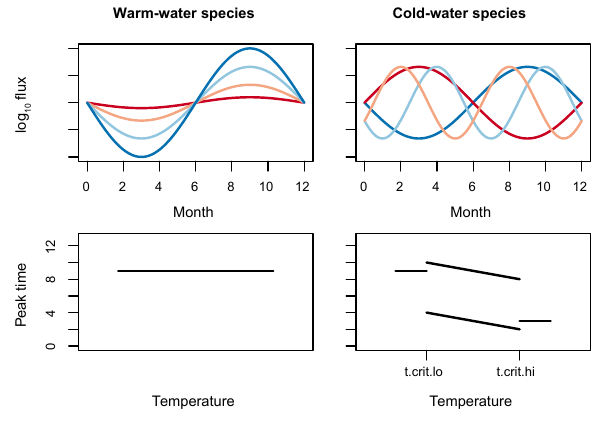
Figure 3. Schematic representation of the seasonality model. Upper panels show the annual flux patterns; colours indicate temperature, where blue is cold and red is warm. Lower panels show the timing of the peak in the year. For a more detailed explanation of the model see Sect. 3.2 and Tables 1 and 2.